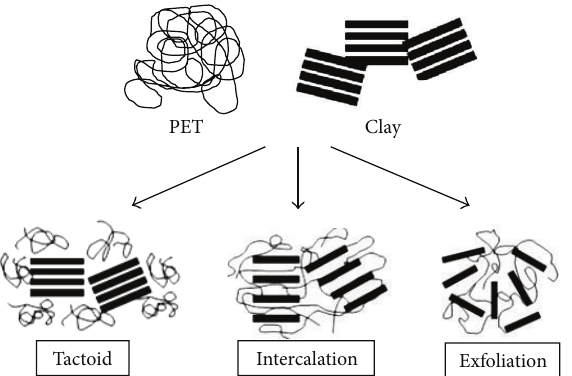
Figure 4: Three types of nanocomposite structures: (a) tactoid, (b) intercalation, and (c) exfoliation structure